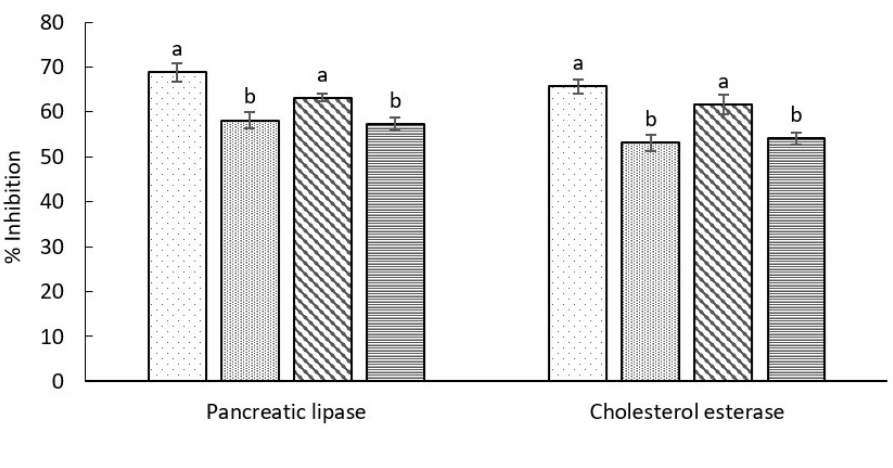
Figure 6. Anti-obesity activity of B-Glu (C) and O-Glu (C). Here, B-Glu (C) represents catechin encapsulated into barley and O-Glu(C) represents catechin encapsulated into oats β -glucan matrix. Different letters on the bars representing same sample before and after digestion indicate significant difference ( p <